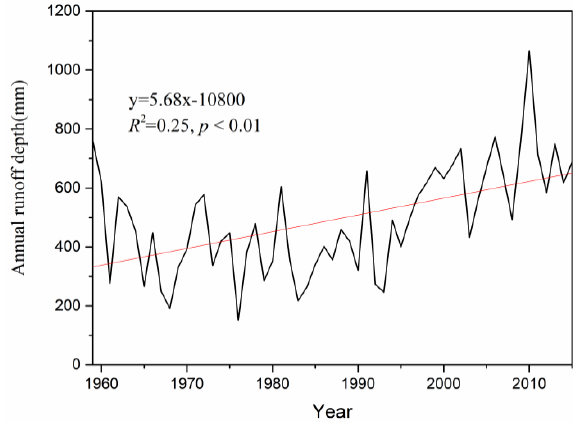
Figure 9. Simulated annual runoff depth in the LHGB from 1959 to 2015.